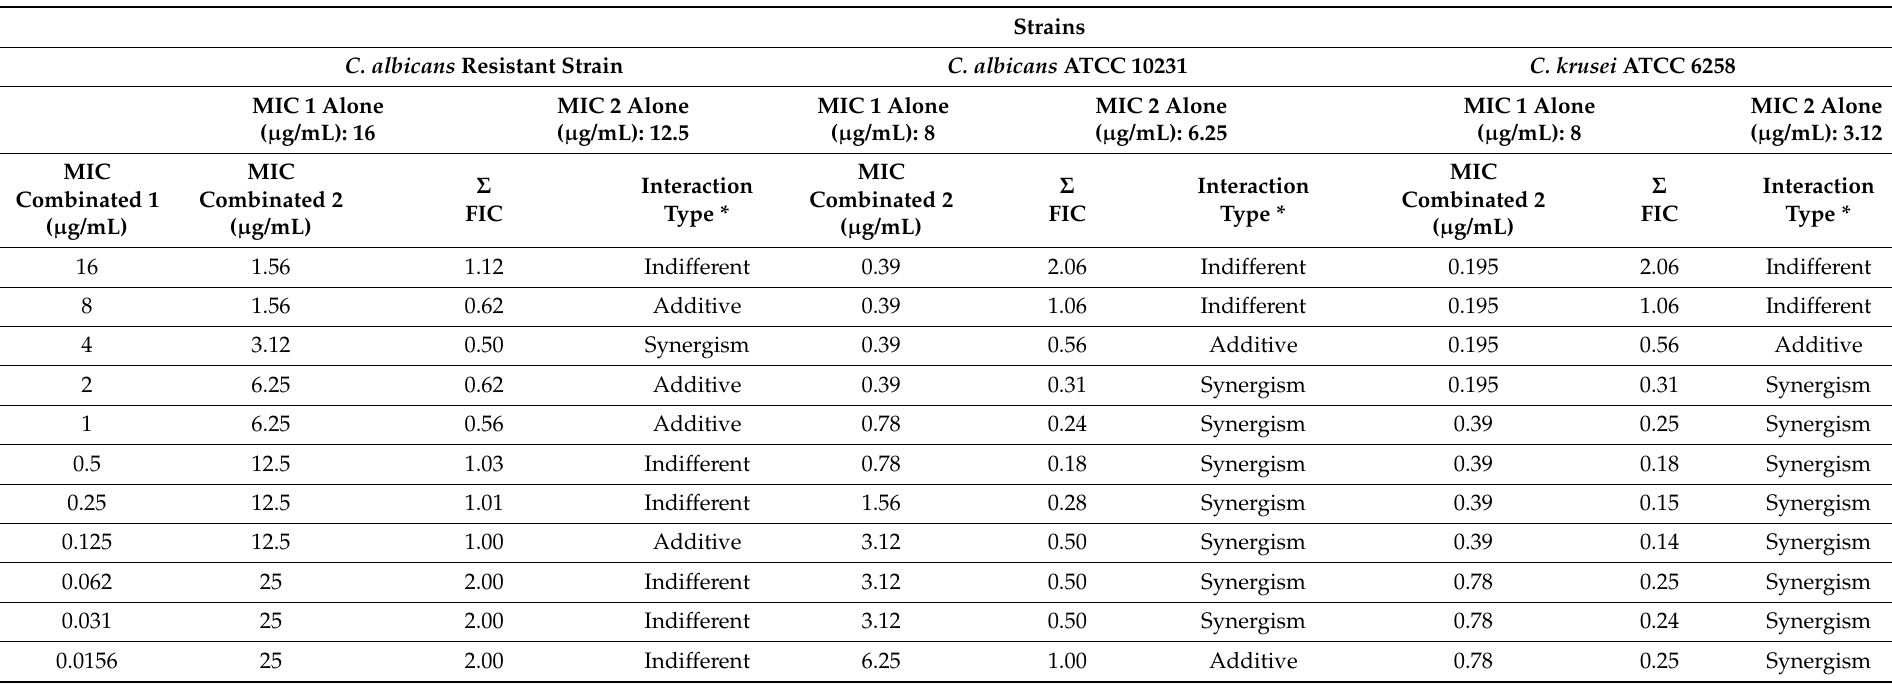
Table 1. Main interactions of amphotericin B (1) with ent -hardwickiic acid (2) in vitro against Candida strains using checkerboard microdilution